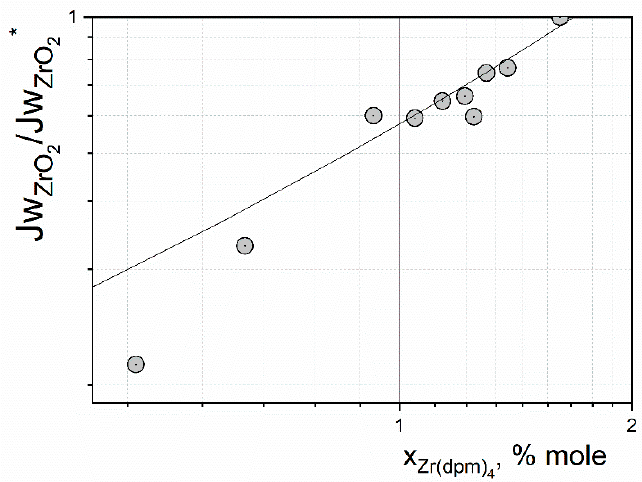
Figure 2. Comparison of analytical estimation with experimental data of [9].